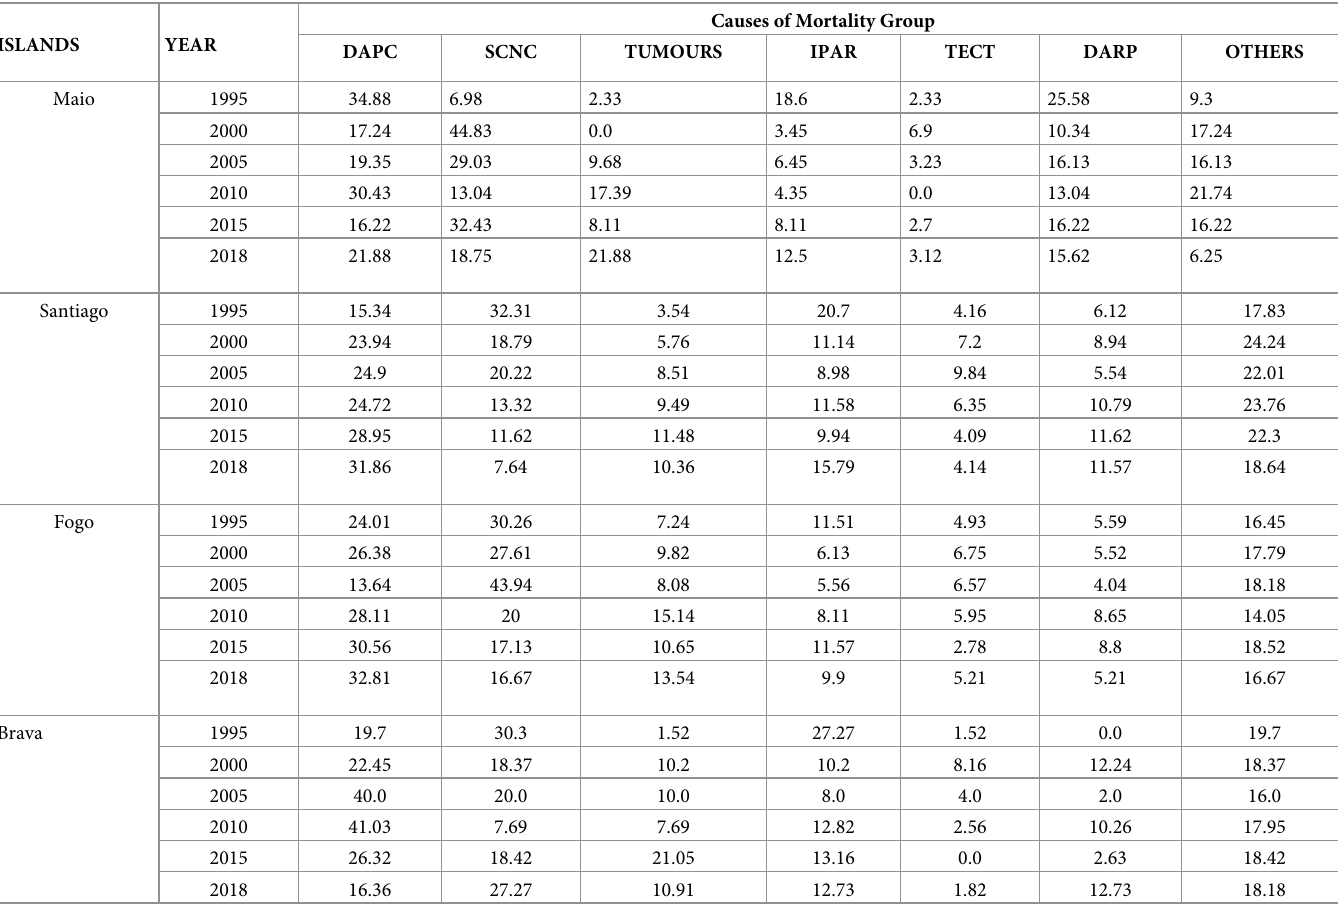
Table 2. Distribution of mortality by group of causes (%) in the Sotavento islands. ISLANDS YEAR